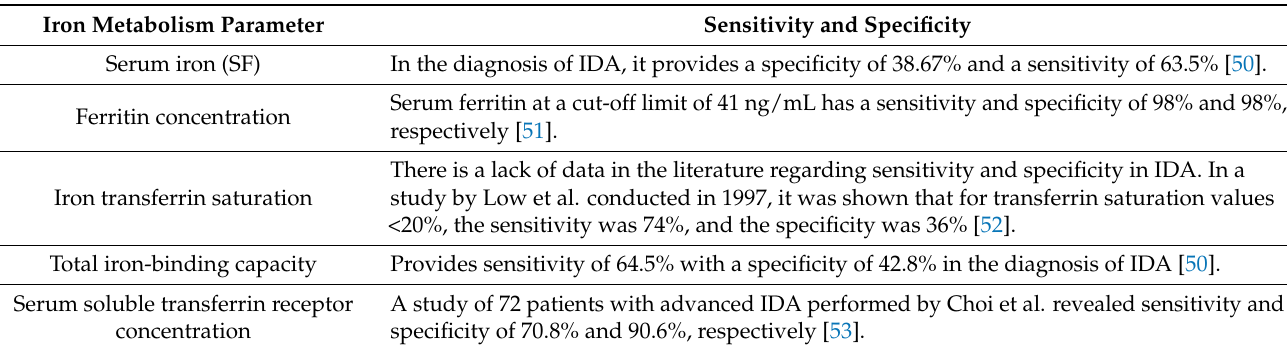
Table 3. The accuracy and reliability of iron deficiency diagnostic